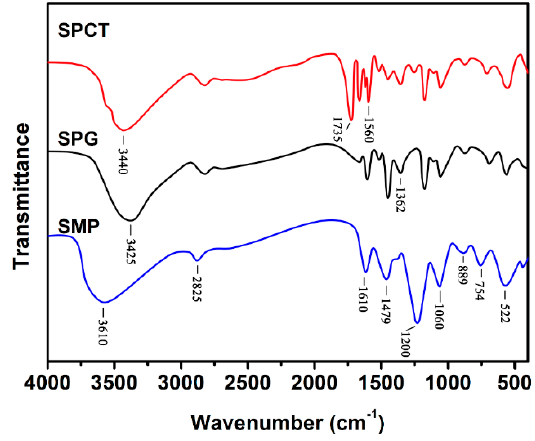
Figure 2. FTIR spectrum of SMP, SPG and SPCT.